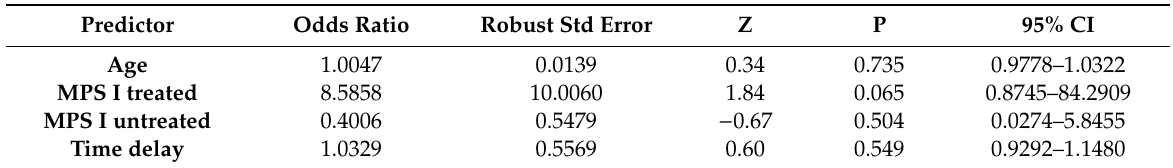
Table 9. DNMP mixed e ff ects logistic regression model. Analysis of MPS I a ff ected groups compared to normal group for choice (correct versus incorrect) at each session x trial and